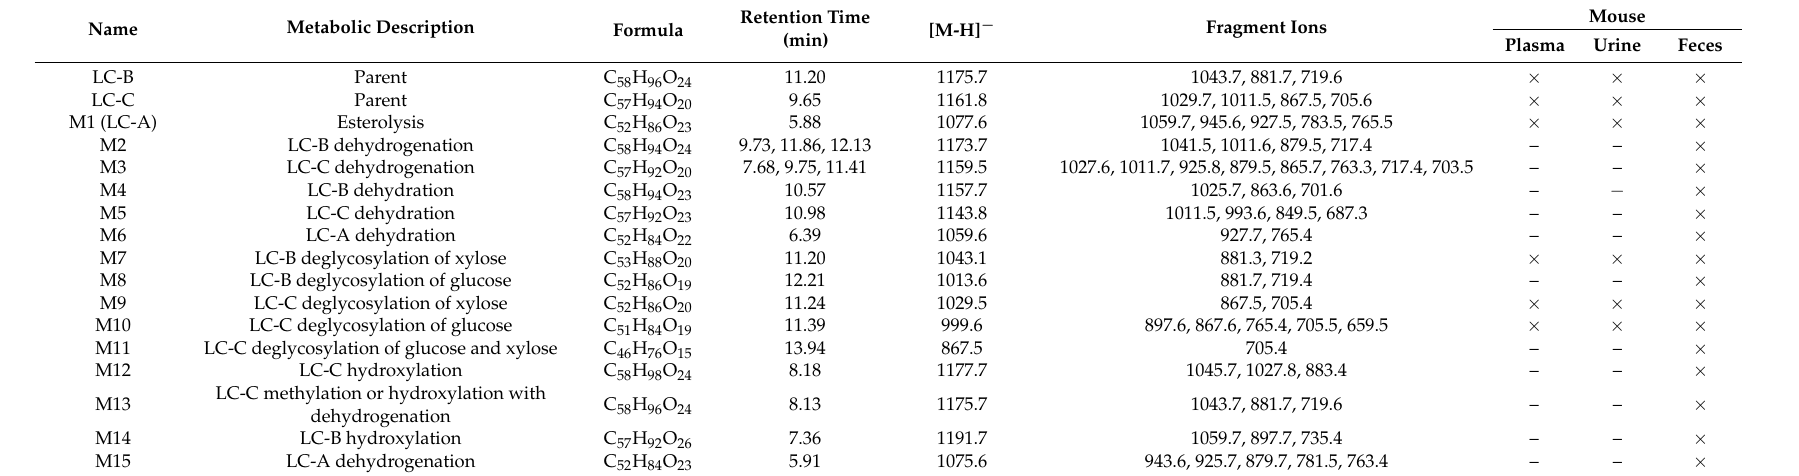
Table 1. Characterization of the metabolites of Capilliposide B (LC-B) and Capilliposide C (LC-C) in mice by